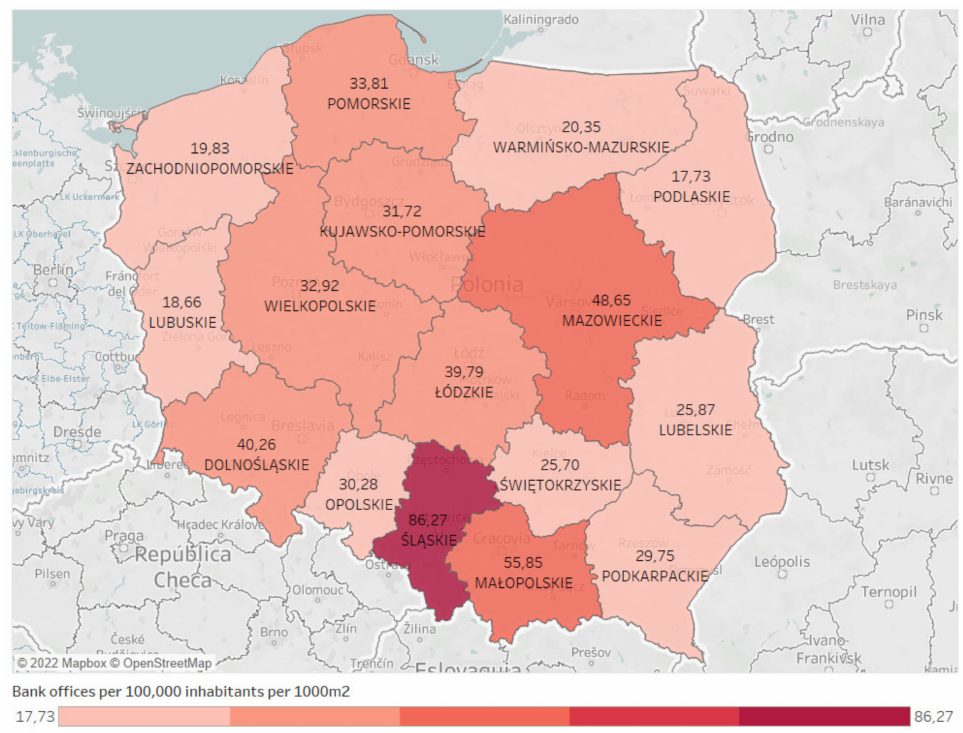
Figure A2. Voivodeships with the fewest bank offices per 1000 m 2 . Source: Own elaboration based on data from Table A1 and Tableau Desktop Professional Edition.